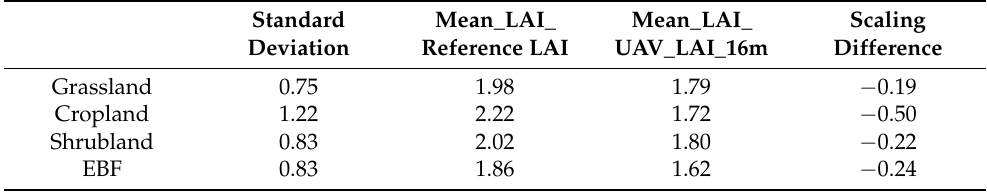
Table 3. Statistical metrics for different vegetation types. The mean LAI is the average LAI for each vegetation type. The standard deviation represents the spatial heterogeneity within the 16 m-resolution pixel. The scaling difference refers to the difference in mean LAI values obtained from two different up-scaling